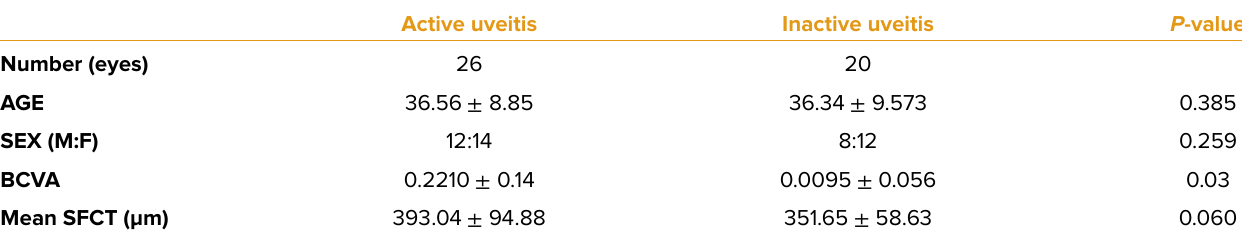
Table 3. Demographic and clinical finding of patients with ocular involvement in both WF-FAG and clinical